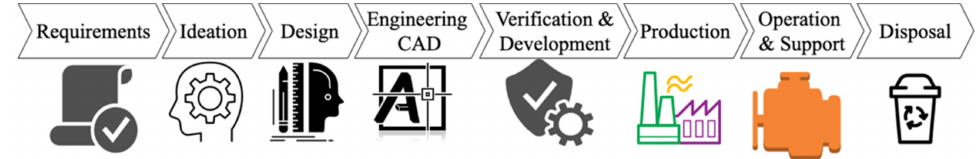
Figure 3. Traditional product life cycle management